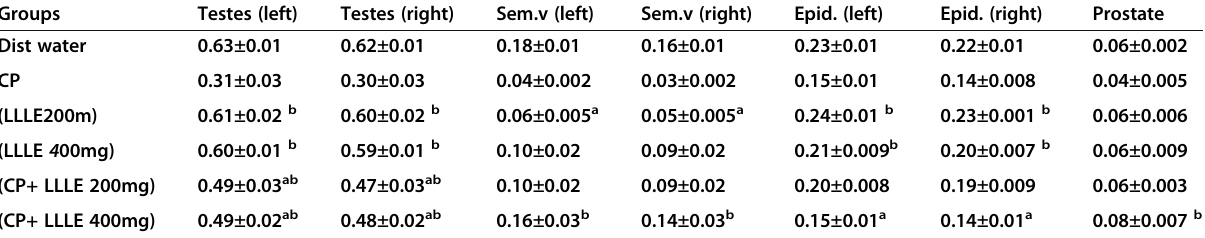
Table 2 Protective effect of oral administration of LLLE for 26 days on the weight of the relative organs in Wistar male rats treated with CP Groups Testes (left) Testes (right) Sem.v (left) Sem.v (right) Epid. (left) Epid.